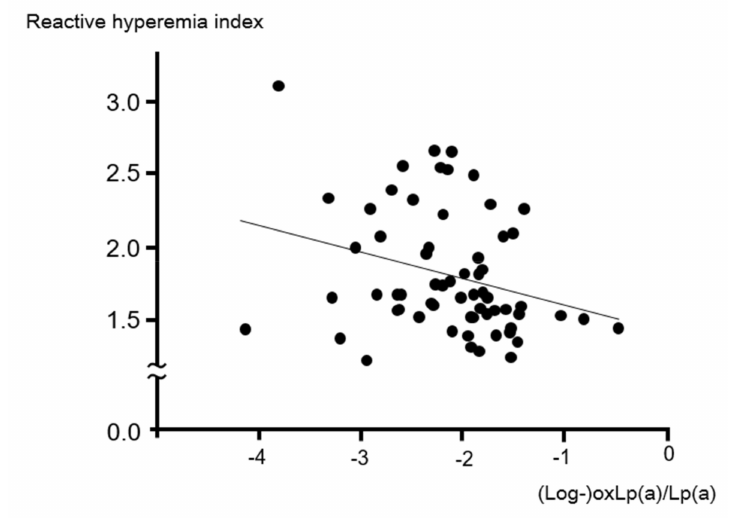
Figure 1. Correlation between the oxLp(a) / Lp(a) and reactive hyperemia